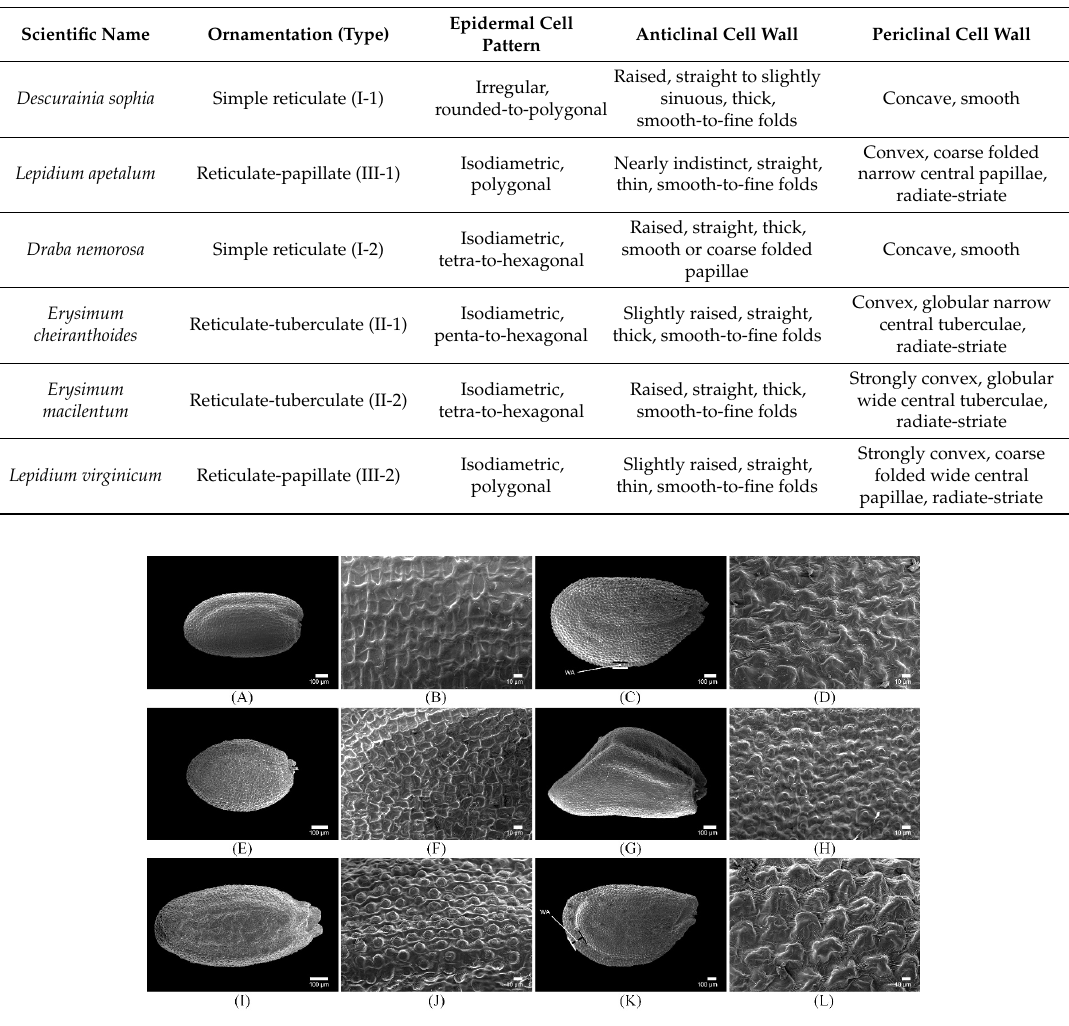
Figure 5. Scanning electron microscope micrographs showing ( A , C , E , G , I , K ) an overview of the seed surface and ( B , D , F , H , J , L ) detailed seed ornamentation. ( A , B ) Descurainia sophia (Type I-1;